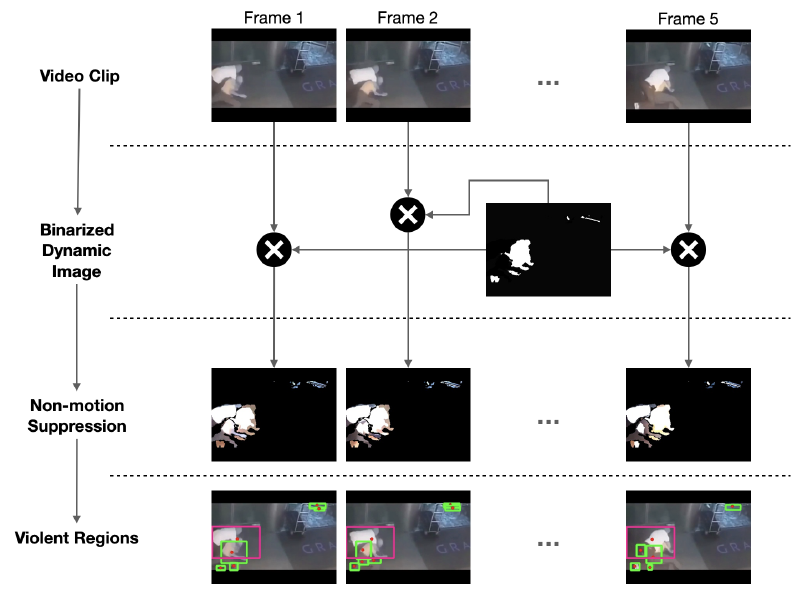
Figure 4. Non-motion Suppression. Each frame in the clip is multiplied by the binarized dynamic image. The third row shows the frames with non-moving regions suppressed. The fourth row shows the connected components (green boxes). The components with more movement (violent) are the pink